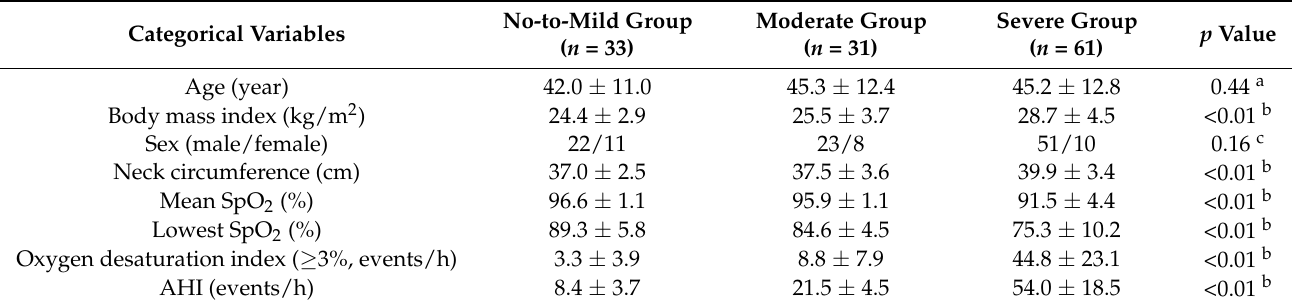
Table 1. Demographic characteristics of participants grouped according to OSA severity and assessed through hospital- based PSG.